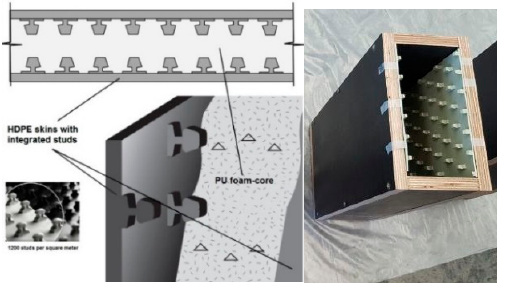
Figure 19. Illustration of the 3-D composite panel with HDPE skins and PU core ( left ) and used formwork ( right ). Adapted from [62].